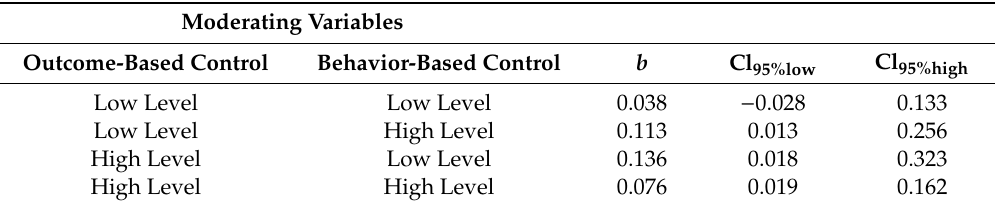
Table 5. Test of the conditional indirect e ff ect of job insecurity on insomnia symptoms through emotional exhaustion with di ff erent levels of outcome-based control and behavior-based control. Moderating